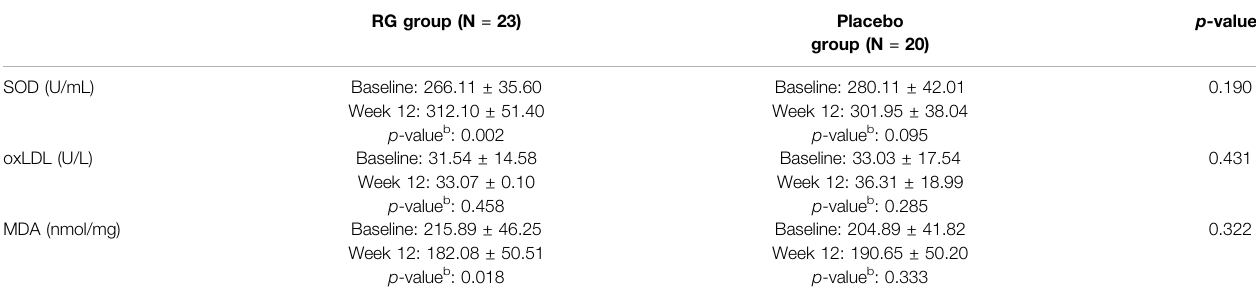
TABLE 6 | Antioxidant enzyme activity and oxidative stress markers at baseline and week 12.